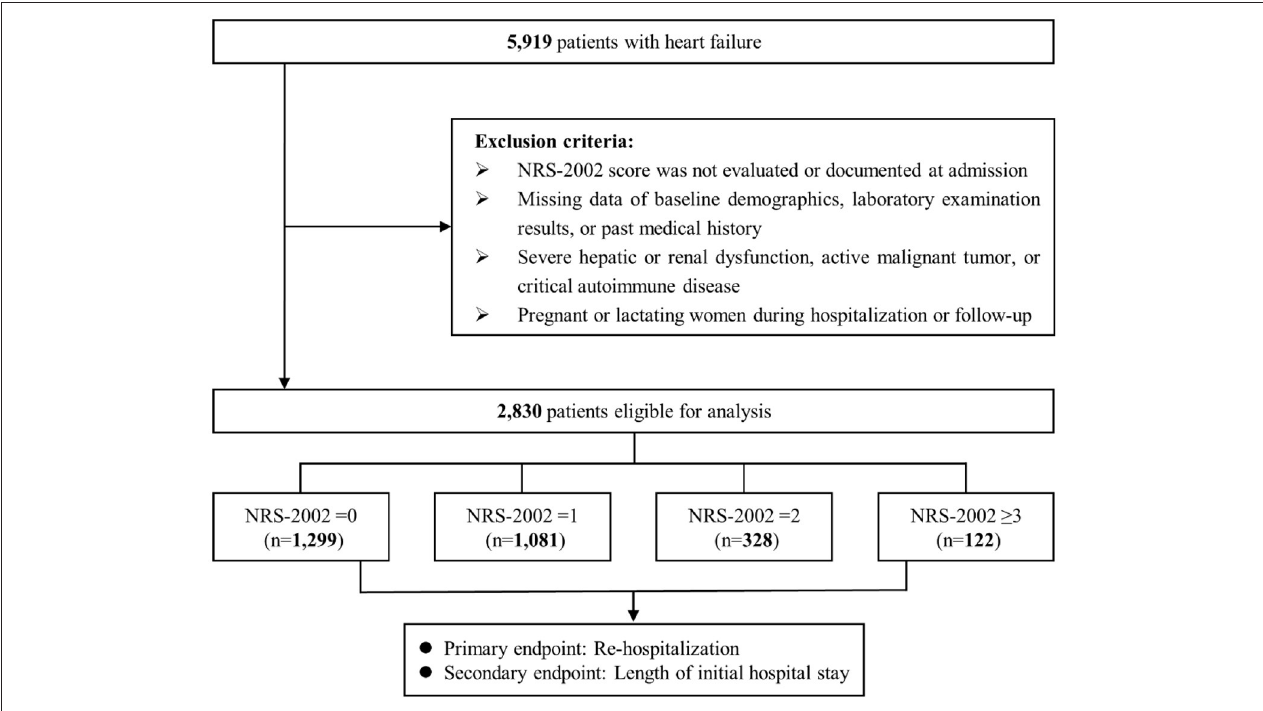
FIGURE 1 | Flow diagram. NRS-2002 indicates Nutritional Risk Screening